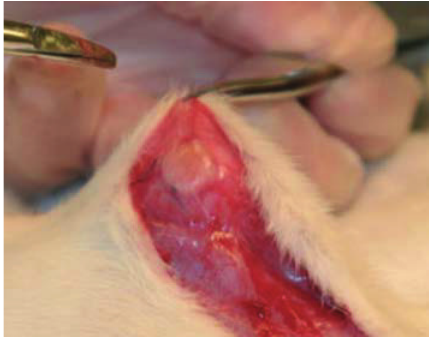
Figure 27: Explantation of implants after 1 week